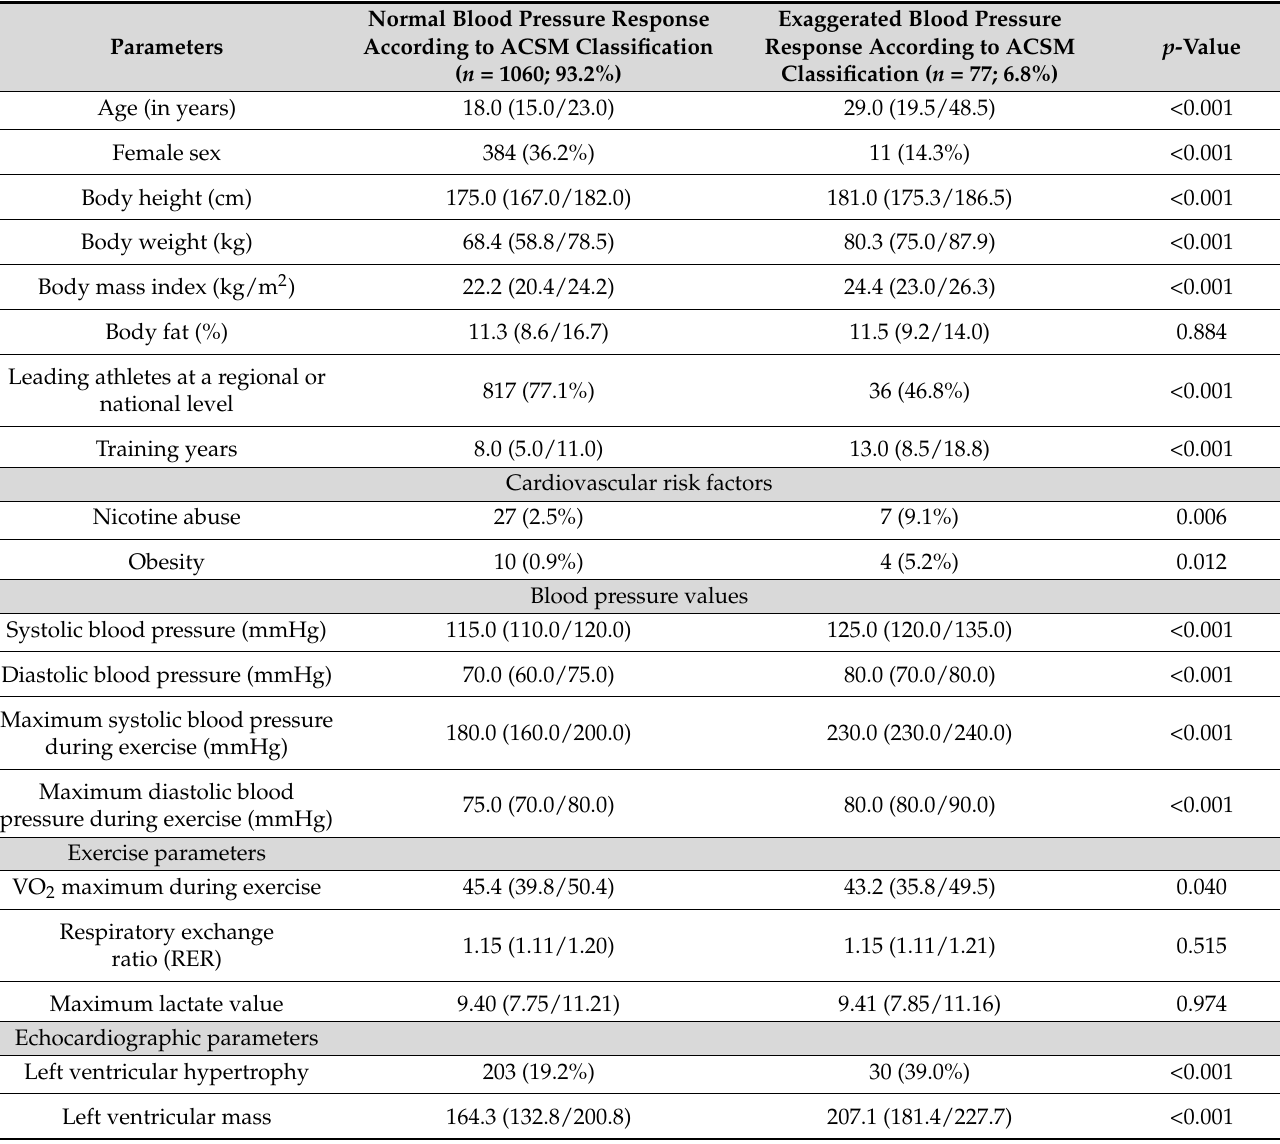
Table 3. Patient characteristics of the 1137 examined athletes without known arterial hypertension stratified for exaggerated blood pressure response according to ACSM